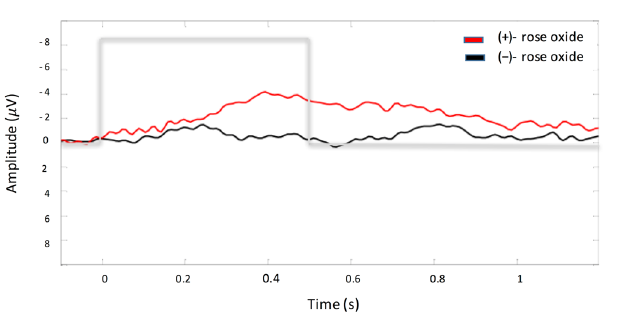
Figure 3. Grand average of EOG in response to ( + )-rose oxide (red line) and ( − )-rose oxide (black line). Grey line presents stimulus starting from 0 s with a sharp onset and duration of 0.5 s.